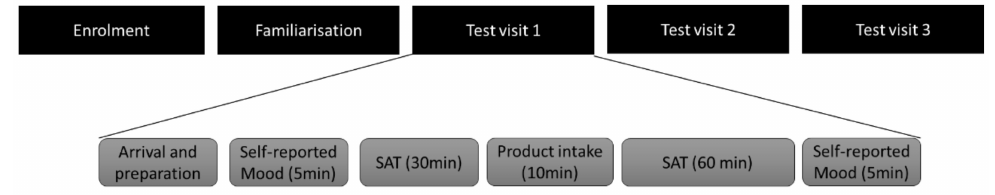
Figure 1. Overview of the study